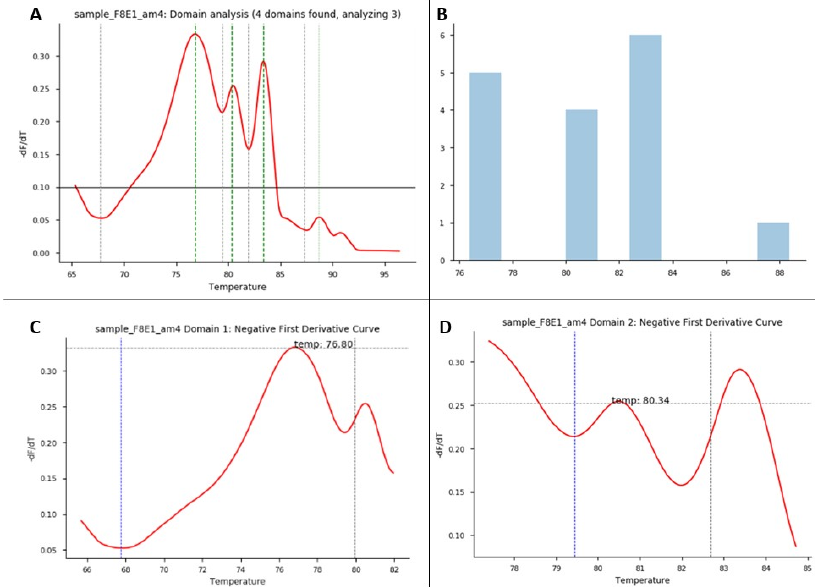
Figure 5. HRM domain analysis . HRM domain analysis for exon 1 of F8 : this experiment consisted of 1 patient as a positive control and 3 healthy controls. ( A ) Domain analysis plot: for each sample/exon, 4 identified domains in the positive control sample. ( B ) Domain analysis plot: for each data run, this